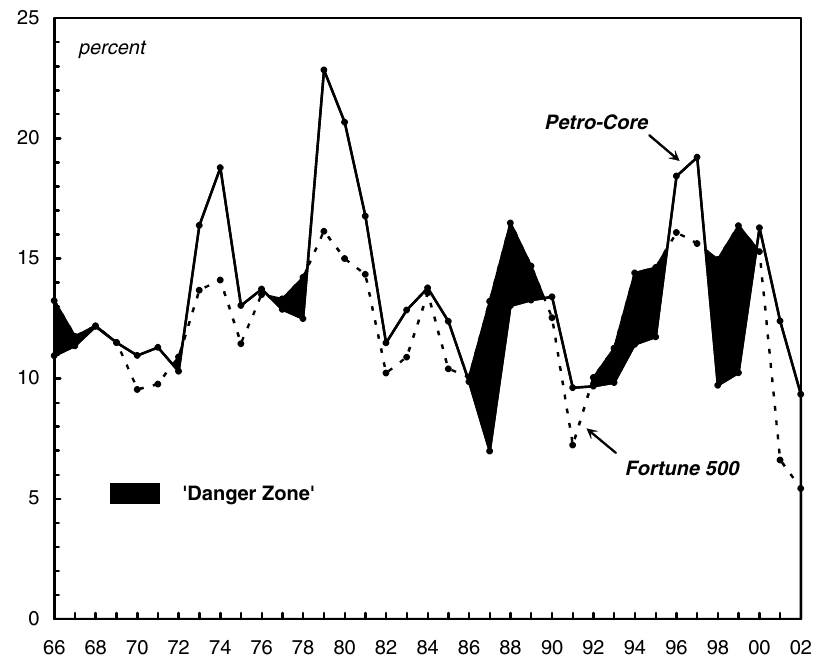
Figure 13 – Return on Equity: The Petro-Core* versus the Fortune 500** Figure 14 – The Petro-Core’s Differential Accumulation* and